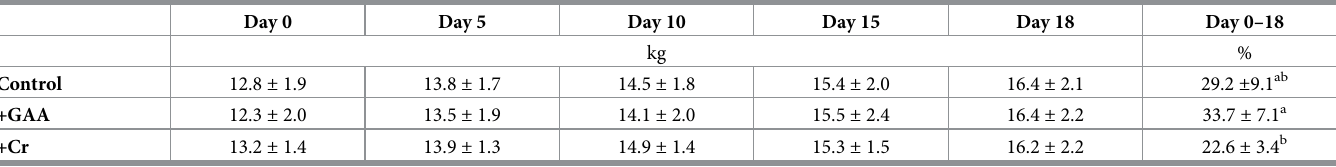
1 Data expressed as mean ± SD. Pigs were supplemented for 18–19 days with 157 mg GAA/(kg � d) ( +GAA ) (n = 8) or with 200 mg Cr/(kg � d) (+Cr ) (n = 8); Control pigs were unsupplemented (n = 14). 2